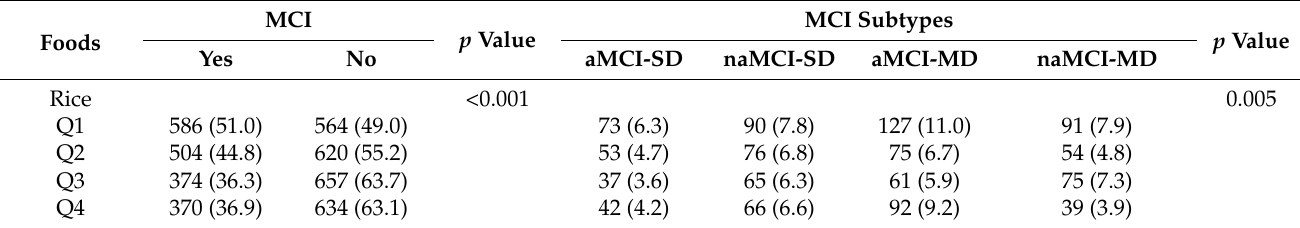
Table 2. Prevalence of MCI and its subtypes of participants according to consumption levels of food subgroups a .